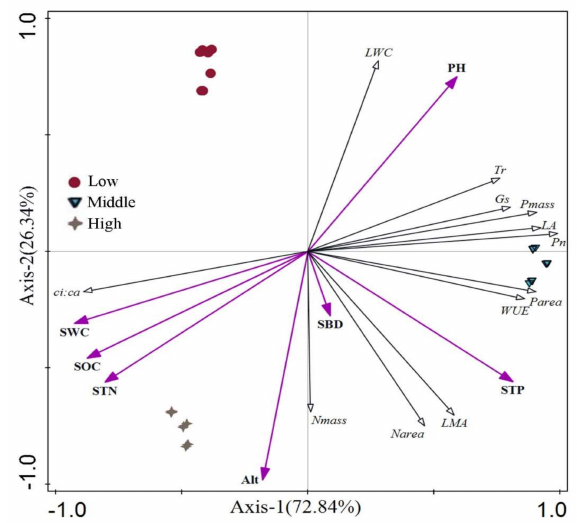
Figure 10. RDA ranking between functional traits of H. tibetana leaves and environmental factors. Low , low altitude. Middle , middle altitude. High , high